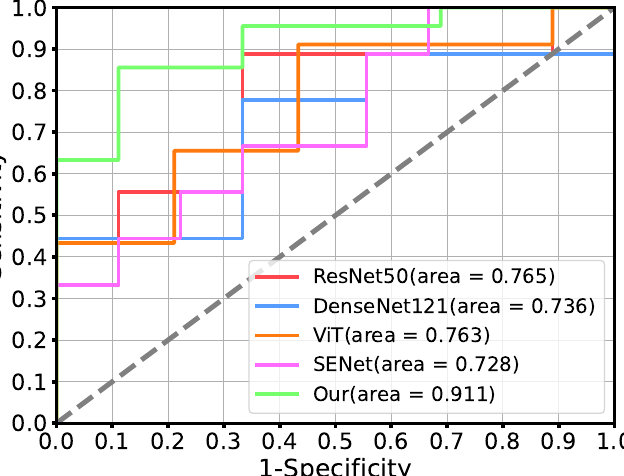
Figure 3. The comparison of receiver operating characteristic curves using different networks in the testing cohort. ResNet50, DenseNet121, ViT, and SENet is the current popular network architecture. Moreover, Our (AUC = 0.911) is the performance of the proposed deep model ResTransNet.